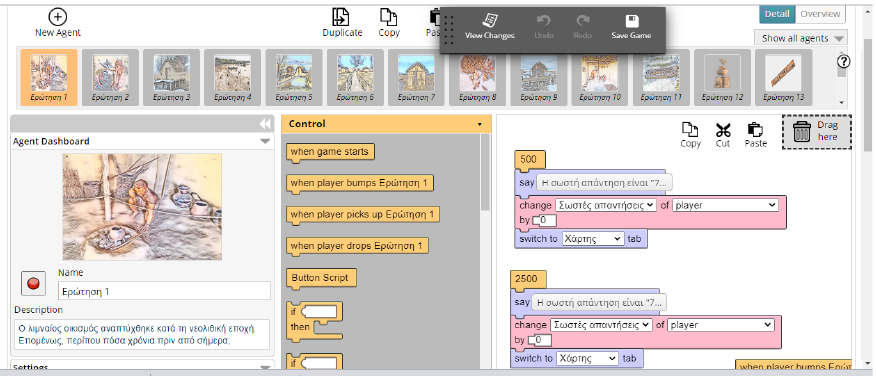
Figure 3. Taleblazer visual block-based programming environment.